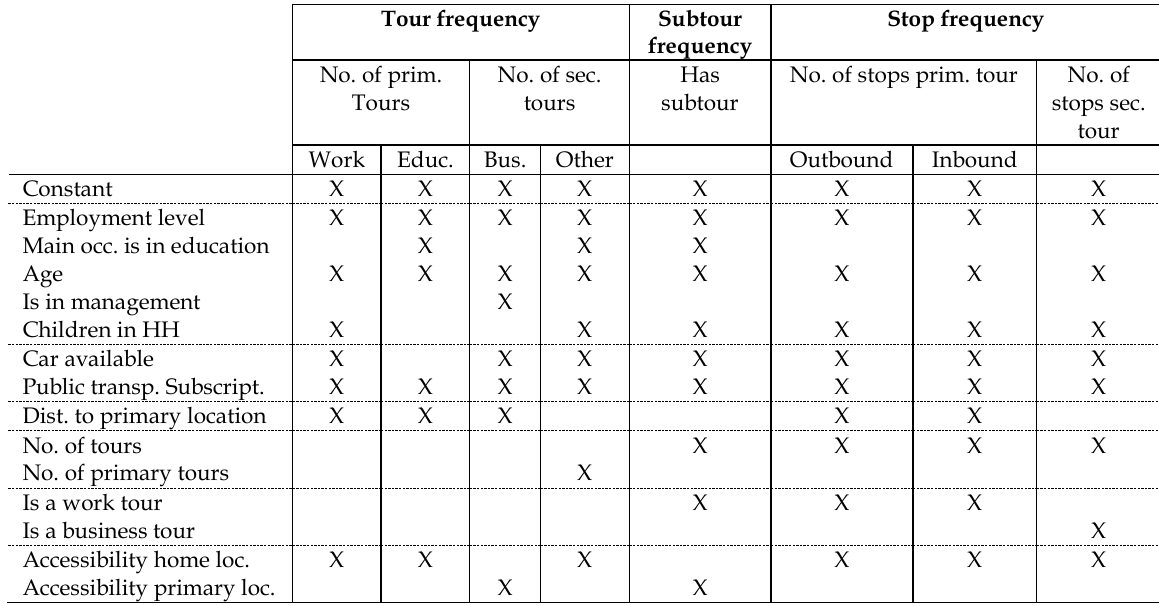
Overview: Multinomial LOGIT models of Tour- and Stop Frequency Tour frequency Subtour Stop frequency